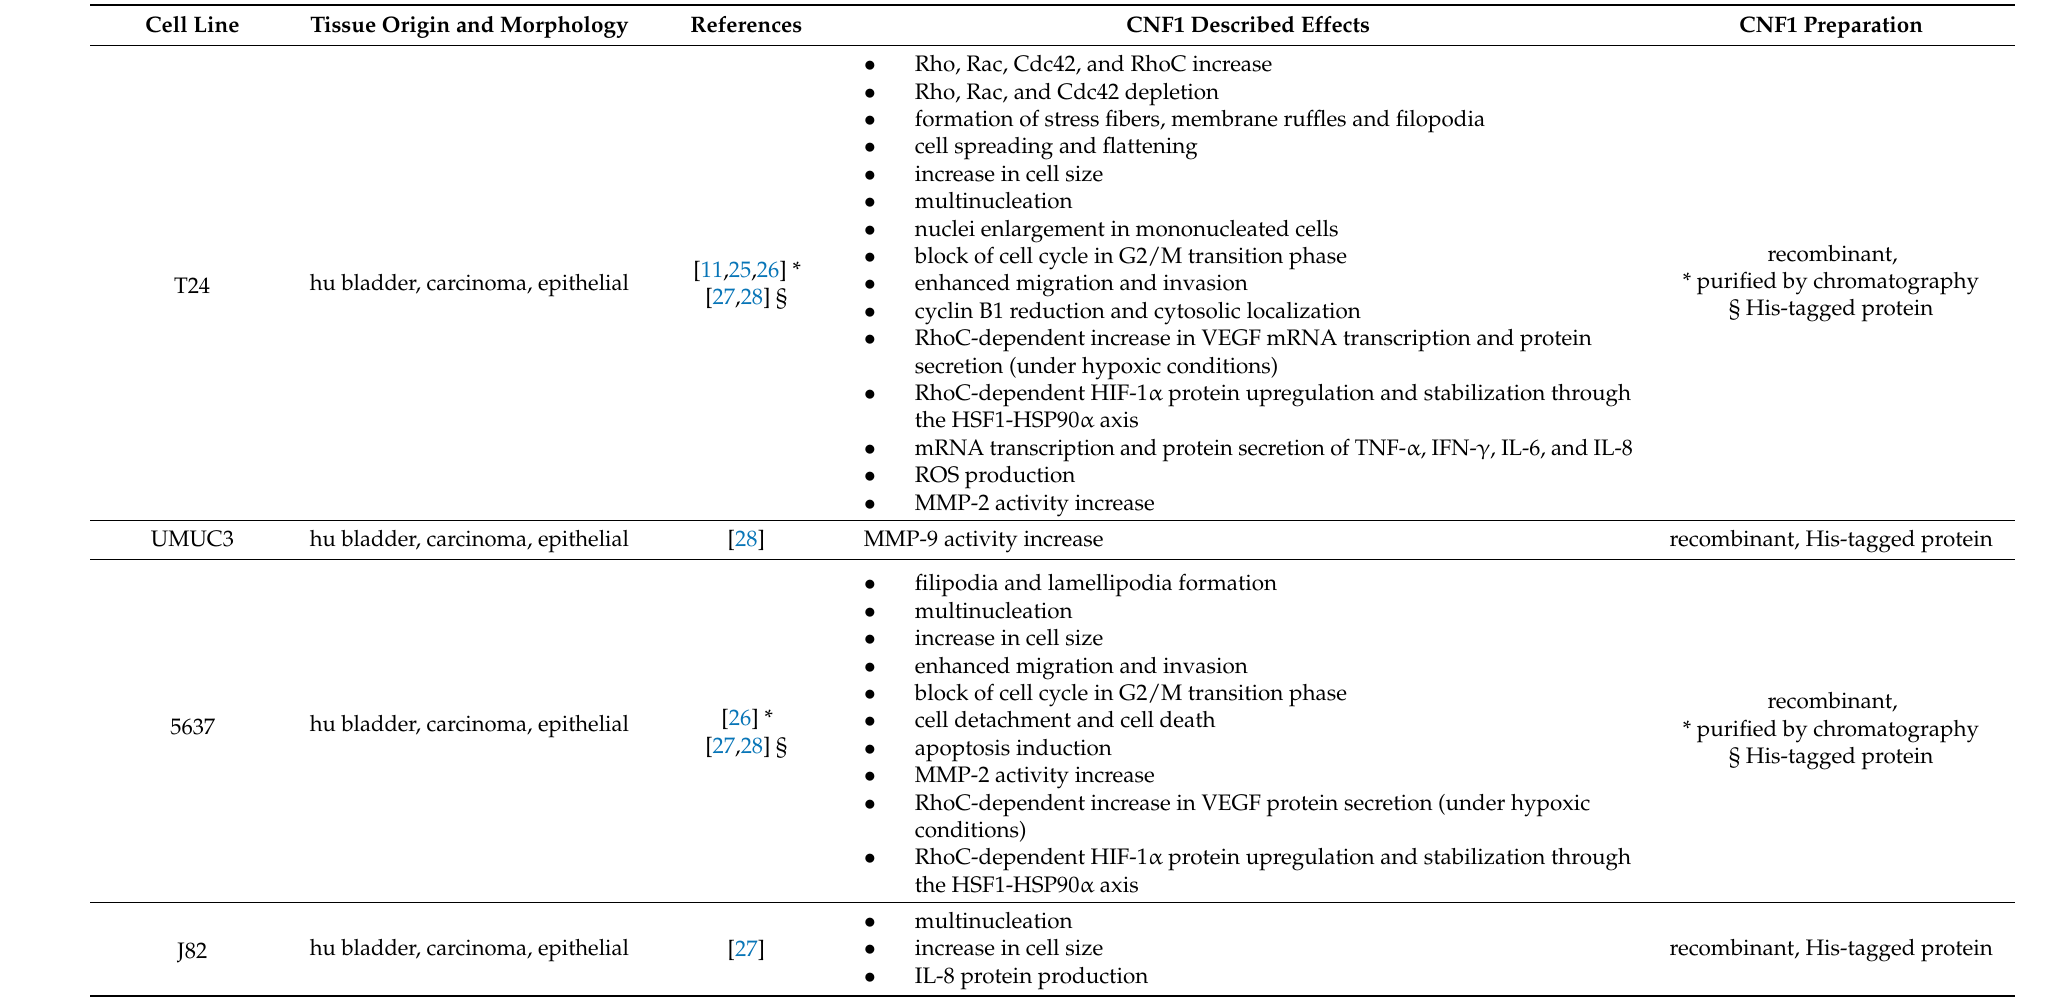
Table 1. Cancer cell